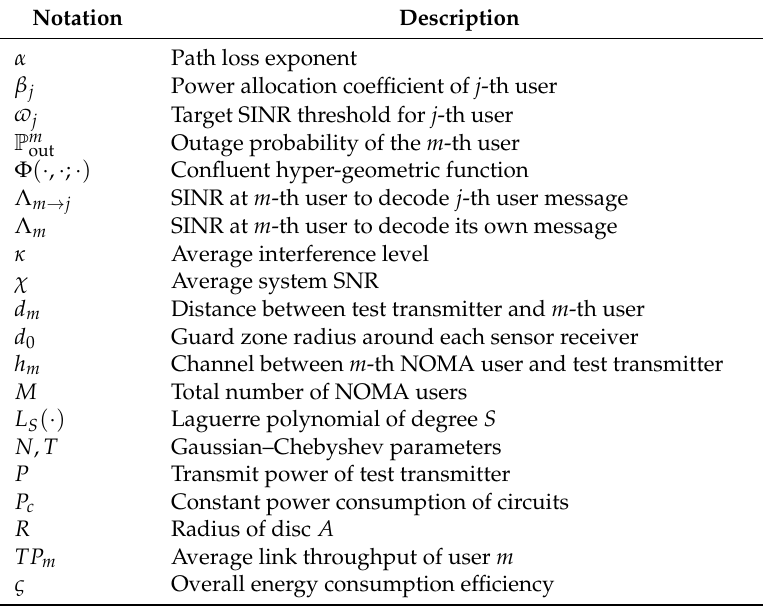
Table 1. Commonly used